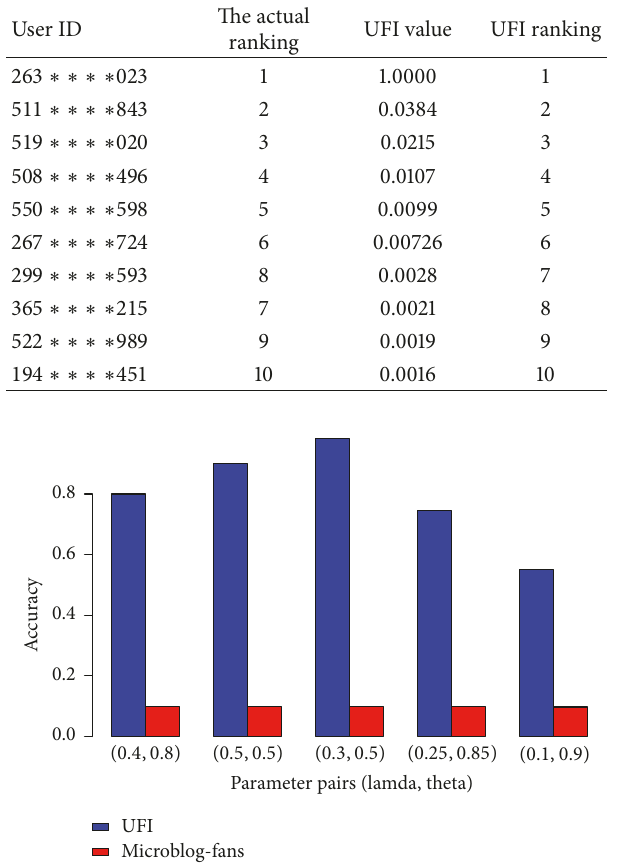
Figure 6: Comparison of accuracy of two methods with different 𝜆 and 𝜃 .